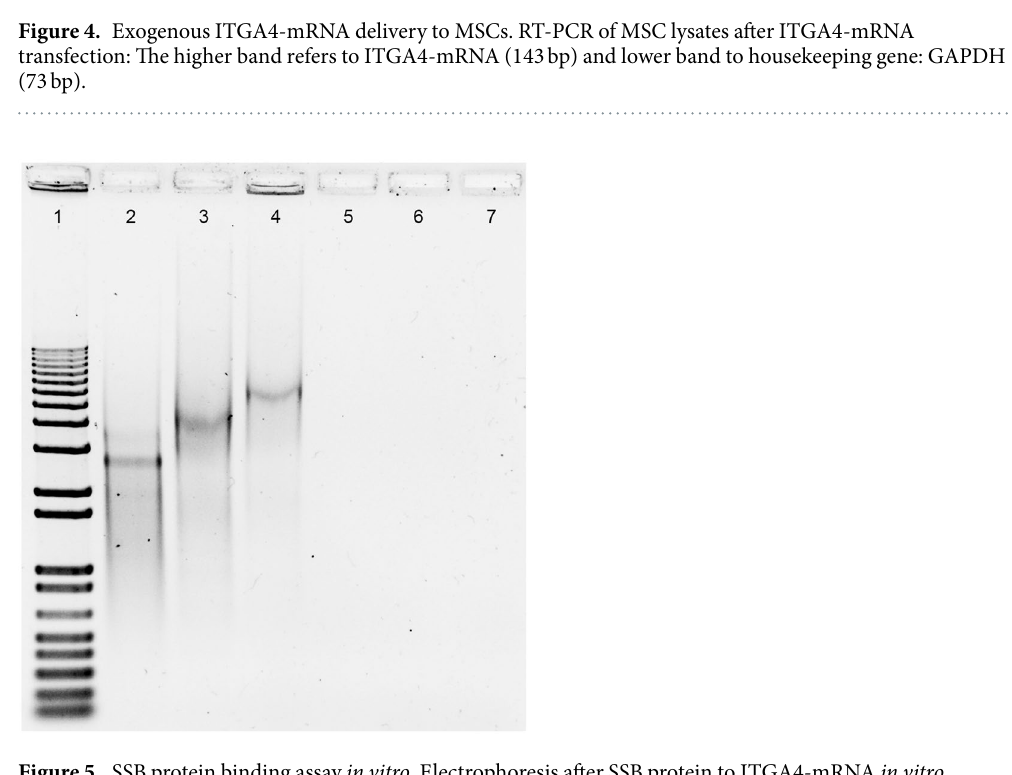
Figure 5. SSB protein binding assay in vitro . Electrophoresis after SSB protein to ITGA4-mRNA in vitro binding assay: 1) 1 kb DNA ladder, 2) ITGA4-mRNA, 3) ITGA4-mRNA/SSB, 4) ITGA4-mRNA/SSB/ Lipofectamine ® 2000, 5) SSB/Lipofectamine ® 2000, 6) SSB, 7) Lipofectamine ®